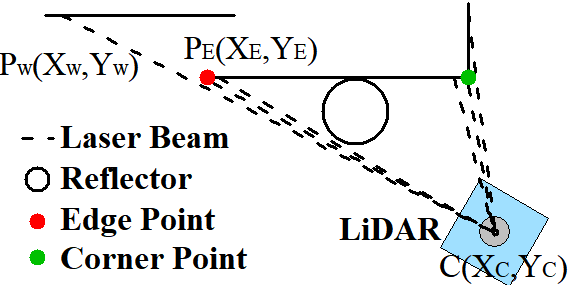
Figure 9. Example of two kinds of boundaries. The red one is called edge point. This type exists at the edge of the wall. The green one is called corner point, which represents the corner of the wall.